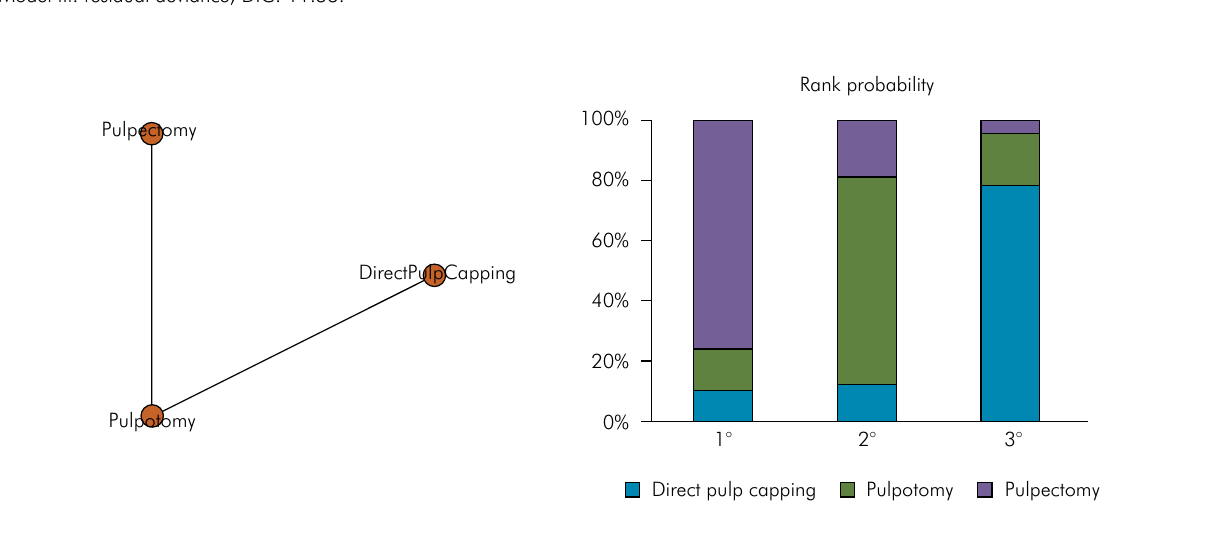
Figure 4. Network comparisons and ranked success probability of treatments for vital pulp accidentally exposed during the caries removal.